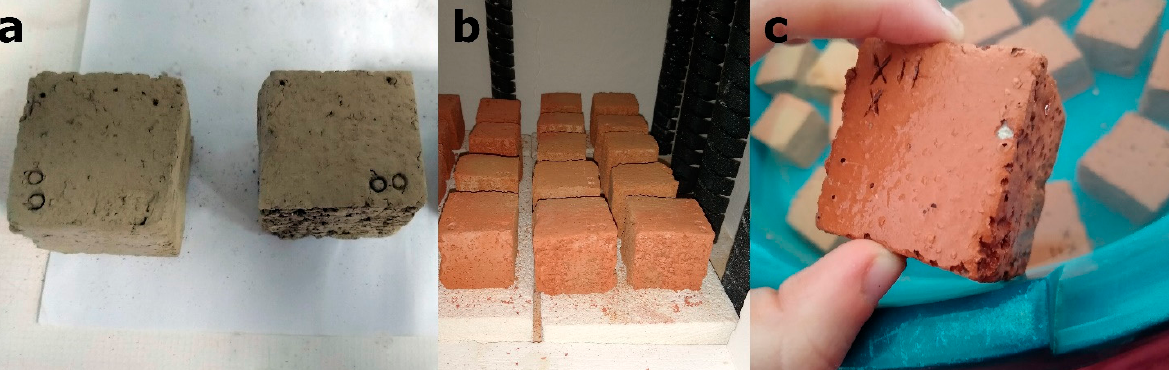
Figure 1. Elaboration of the brick samples: ( a ) unfired cut samples; ( b ) fired samples in the electric oven; ( c ) samples immersed in water to avoid “lime blowing” phenomenon.